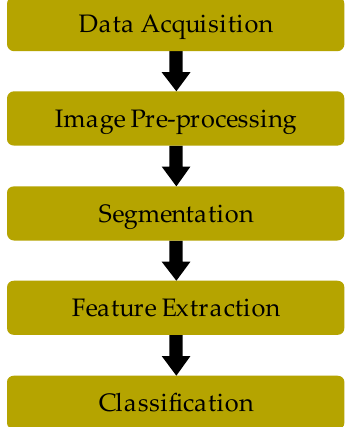
Figure 7. Stages of vision-based systems.